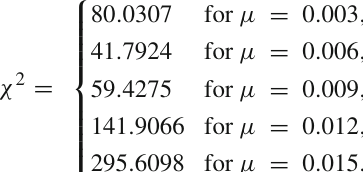
= 0 . 7 which are same as the values chosen to − 1 / 3 , (cid:15) DE 0 plot Fig. 7 with five different values of μ mentioned in the panel. The values of χ 2 obtained for different values of μ